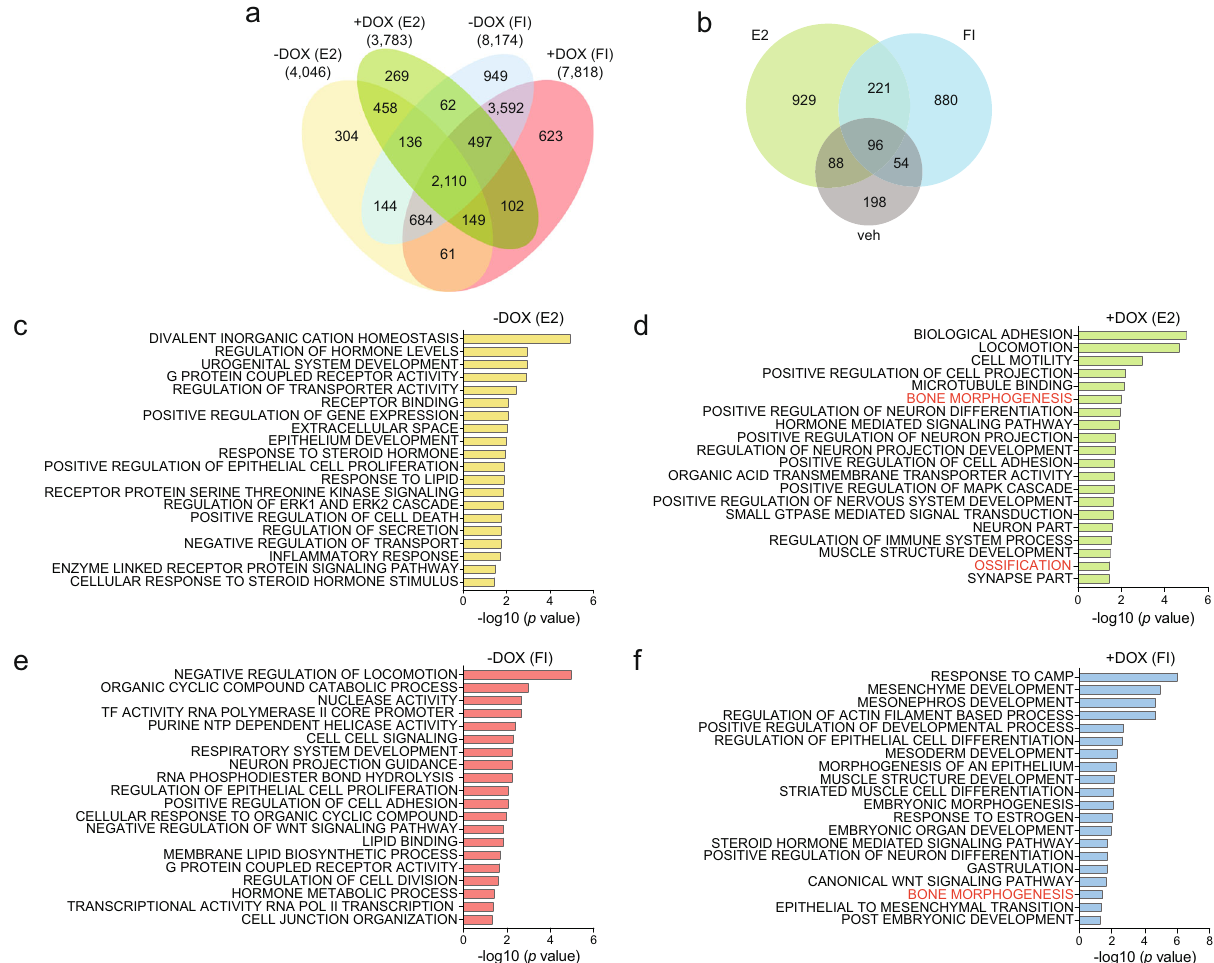
Fig. 4 ZEB1 reprograms the ER α transcriptome to promote an EMT phenotype of breast cancer cells. a Venn diagram showing the overlap of the differentially expressed genes for MCF7-V-ZEB1 cells with ( + DOX) or without ( − DOX) ZEB1 expression in presence of indicated treatments. Fold changes were calculated relative to values from − DOX (veh) ( n = 2 biologically independent experiments). b Venn diagram of the veh, E2- or FI-induced transcriptome changes dependent on ZEB1 expression. c – f Bar plots of a GSEA showing the – log10 ( p value) of the top 20 unique GO terms associated with signi fi cantly altered mRNA expression levels upon E2 – or FI-induced ER α activation in cells with ( + DOX) or without ( − DOX) ZEB1. E2 and FI stand for 17 β - estradiol and forskolin + IBMX, respectively. In all panels only genes up/downregulated by at least 1.3-fold were considered for the analysis. Only the genes that had an FDR < 0.05 were included in the analyses. Source data are provided in Supplementary Data 3 –